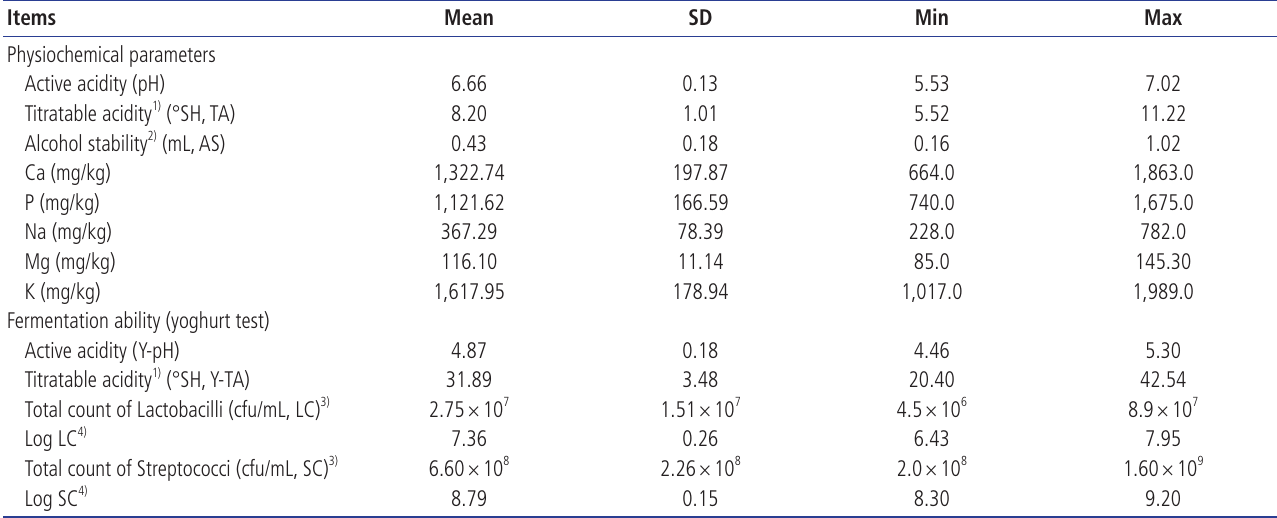
Table 1. Descriptive statistics for milk physiochemical parameters and fermentation ability (yoghurt test with microbial culture of Lactobacilli and Streptococci, n = 338)